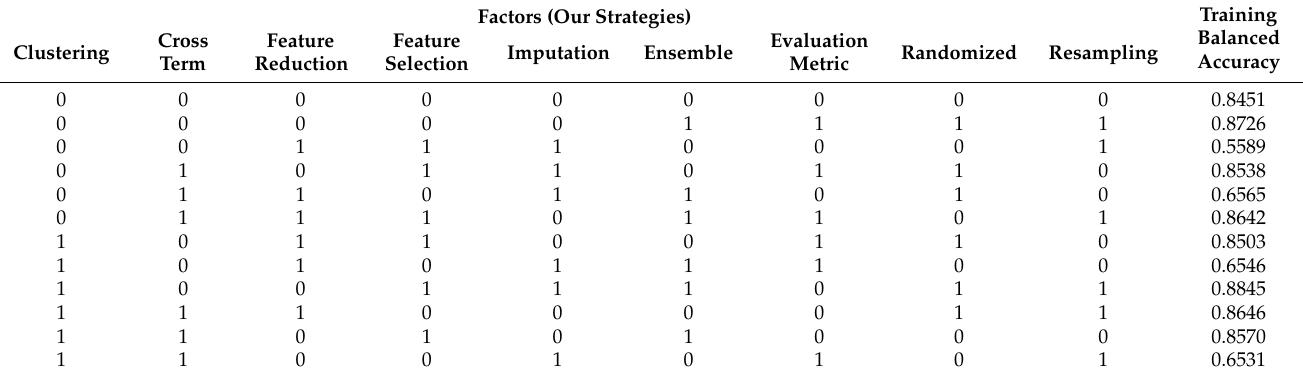
Table 1. The resulting design matrix for third-stage CKD deterioration classification. Factors (Our Strategies) Training